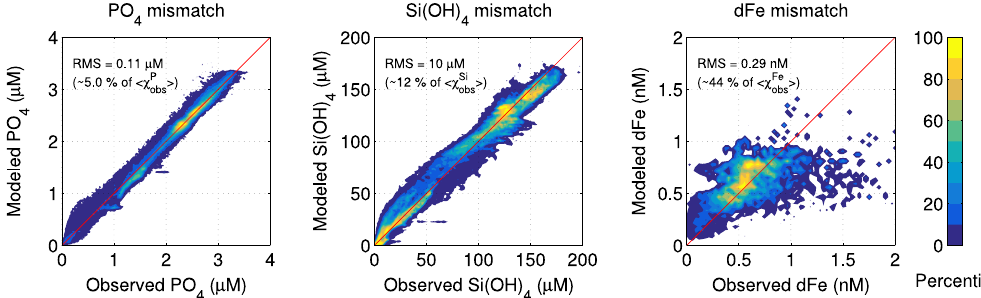
Figure 2. Joint distribution of the cost-weighted observed and modeled concentrations of PO 4 , Si ( OH ) 4 , and dFe. The percentiles of the cumulative distribution are defined such that x % of the distribution lies outside the x -percentile contour. Large percentiles thus correspond to high densities. For PO 4 and Si ( OH ) 4 , the WOA13 observations were interpolated to our model grid. The dFe observations were interpolated to our model grid from the data compilation of Tagliabue et al. (2012) and from the GEOTRACES Intermediate Data Product 2014 (Mawji et al., 2015).